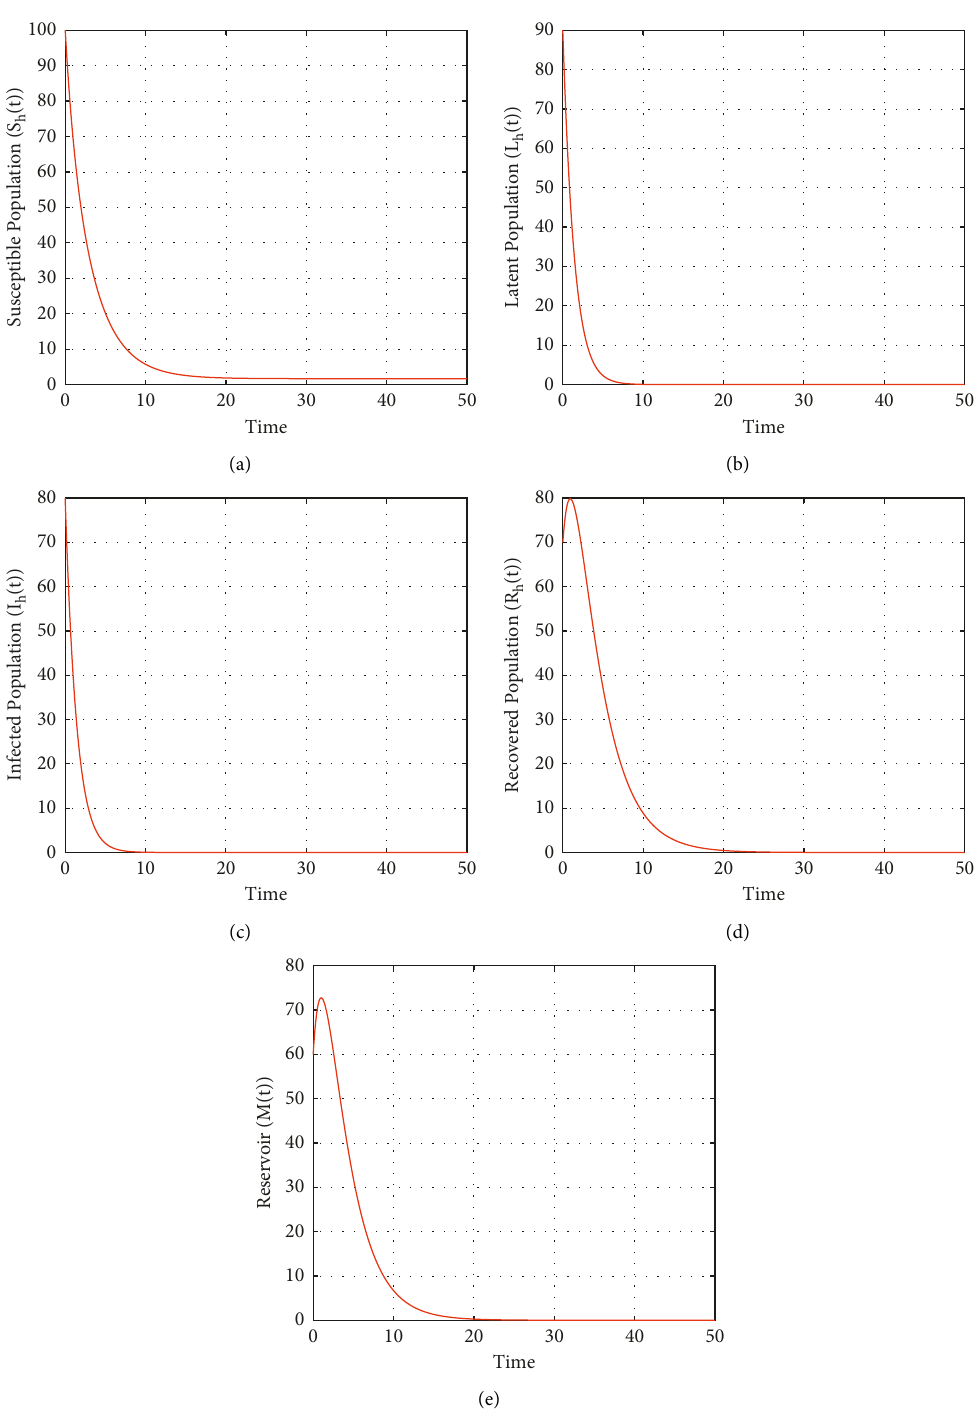
) , where the value of epidemic 1 � 0 . 0000001, c � 0 . 5, c � 0 . 005, d � 0 . 02, 1 2 3 1 < 1.(a) Susceptible– S h ( t ) . (b) 0